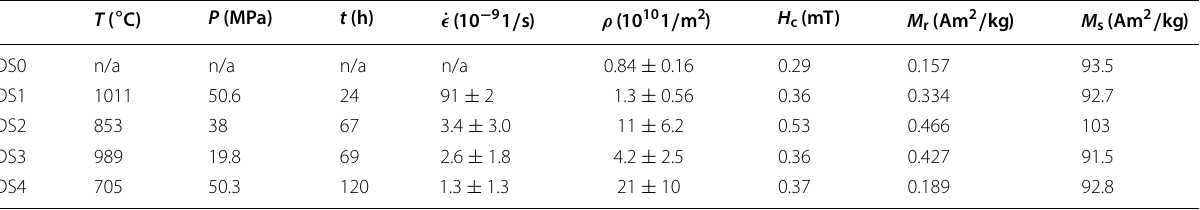
Table 1 Summary of deformation conditions from Lindquist et al. (2015), with resulting strain rate, dislocation density, and hysteresis parameters. DS0 is the undeformed sample. T is temperature at which deformation occurred, P is applied pressure during deformation, t is duration of deformation experiment, ˙ ǫ is strain rate, ρ is dislocation density as measured from etched samples imaged in the SEM, H c is coercivity, M r is magnetic remanence, and M s is the saturation